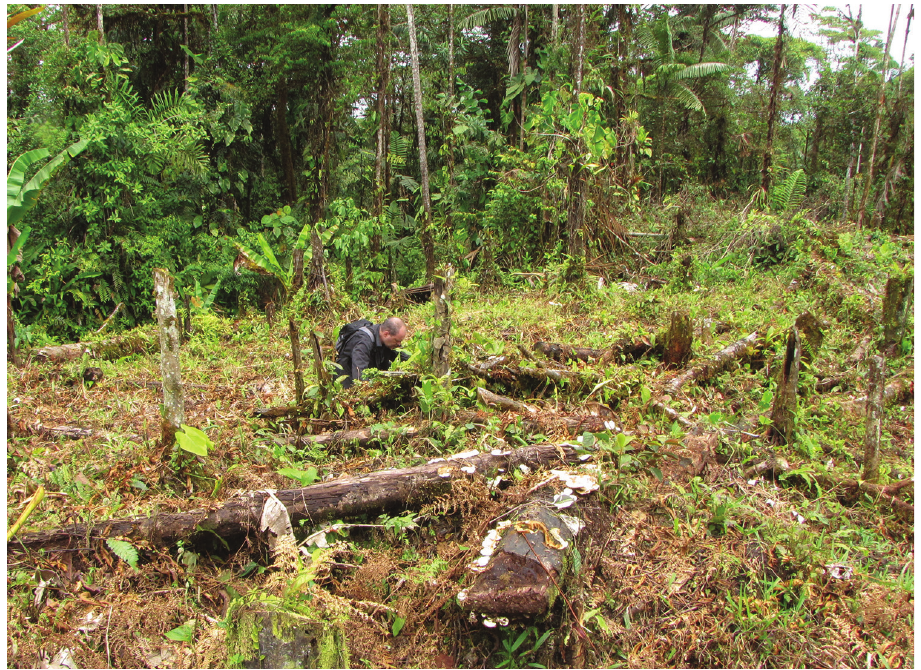
Figure 10. Esmeraldas Province, Ecuador. Natural habitat of Teuthraustes kuryi sp. n. (photograph A. Chagas Júnior; A.B. Kury in the